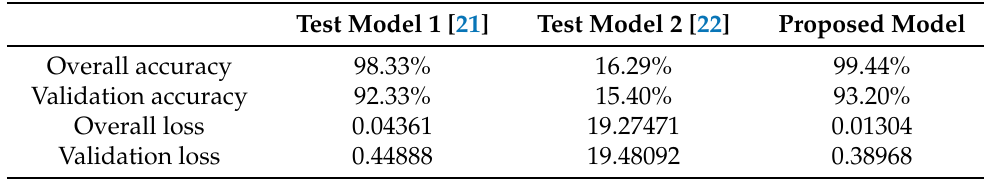
Table 7. Second observation of the first experiment after 100 epochs of training.